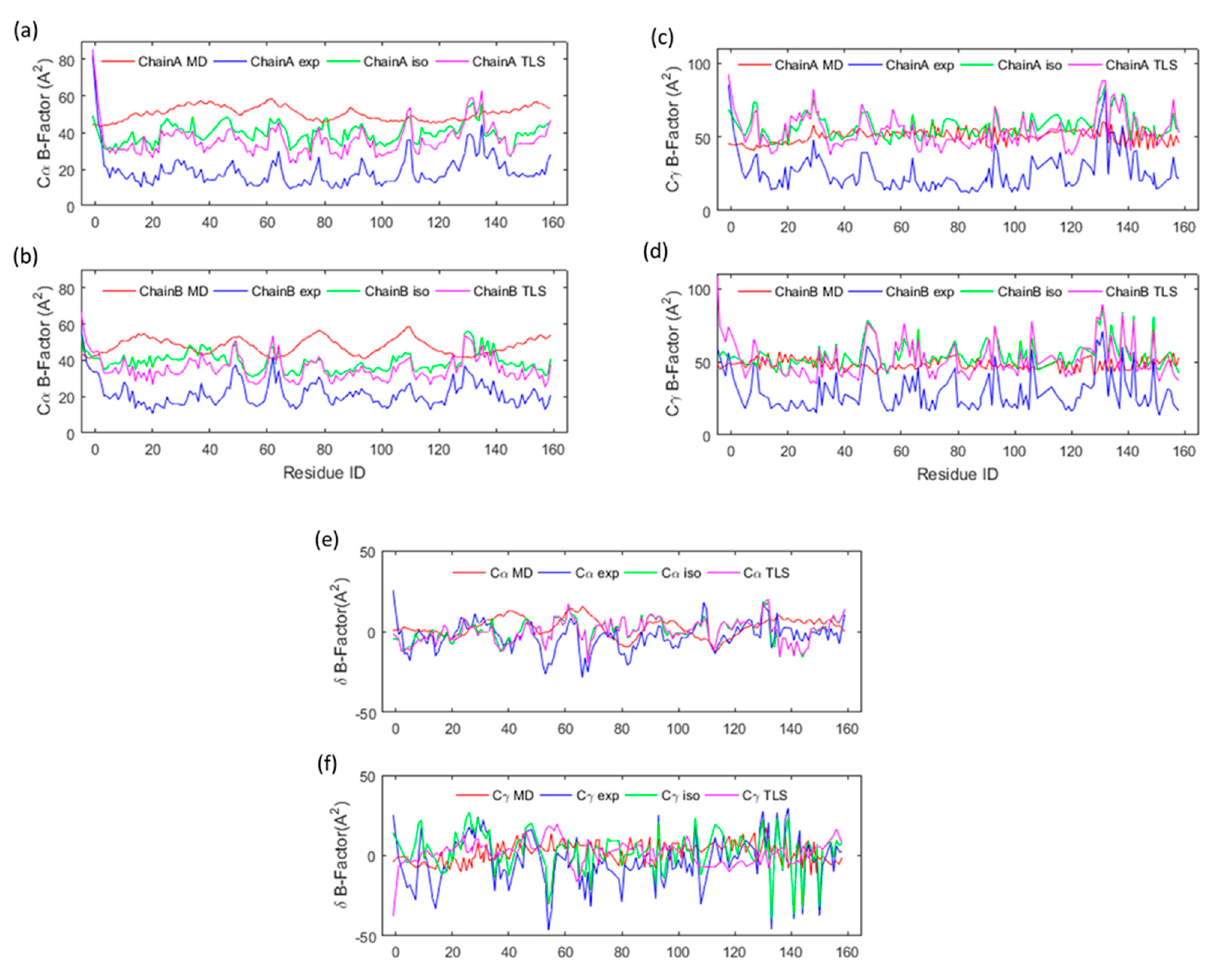
Figure 3. Plots of Hyp-1 ADPs: calculated directly from atom-positional RMSF (red line), experimental from the Protein Data Bank (PDB) entry 3IE5 (blue line), from model re-refined with isotropic thermal motions (green line) and model re-refined using translation–libration–screw model (TLS) groups (purple line). In individual panels ADPs for all CA (C α ) and CG (C γ ) atoms separated on chains A ( a , c ) and B ( b , d ) were shown. Differences in ADPs’ values for both protein chains were calculated between corresponding C α ( e ) and C γ ( f )